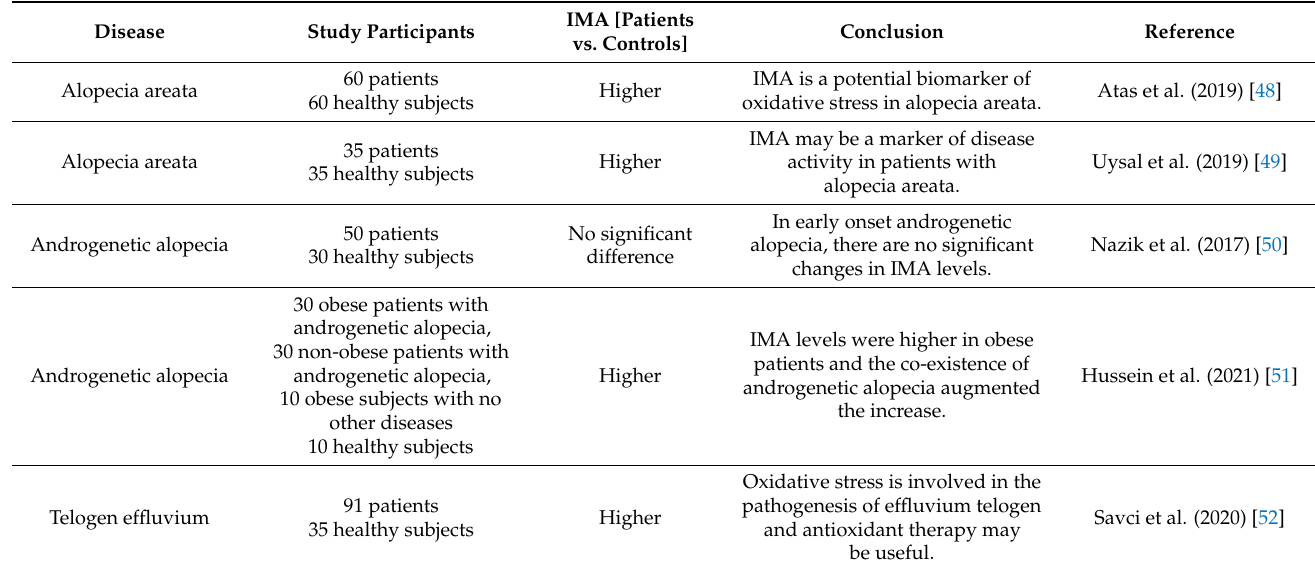
Table 2. The results of the studies that evaluated serum IMA levels in hair